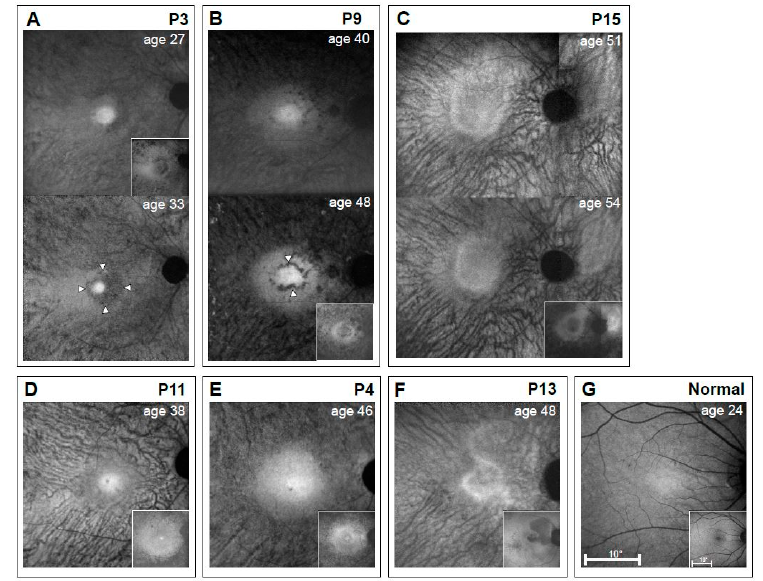
Figure 6. Autofluorescence imaging results of the macula of a representative normal subject compared with 6 EYS patients. Melanin autofluorescence with Near-infrared reduced-illuminance autofluorescence imaging (NIR-RAFI) is shown in the main panels, and lipofuscin autofluorescence (when available) with short wavelength (SW)-RAFI is shown as insets (lower right panels). ( A – C ) Serial data from P3, P9, and P15 are over six, eight, and three years, respectively. ( D – F ) P11, P4, and P13 have images at single timepoints. ( G ) Images from a 24-year-old normal subject. All eyes are displayed as equivalent right eyes and images are individually contrast stretched for visibility of features. Arrowheads in P3 (age 33) and P9 (age 48) indicate hypo AF rings around the hyper AF central signal.